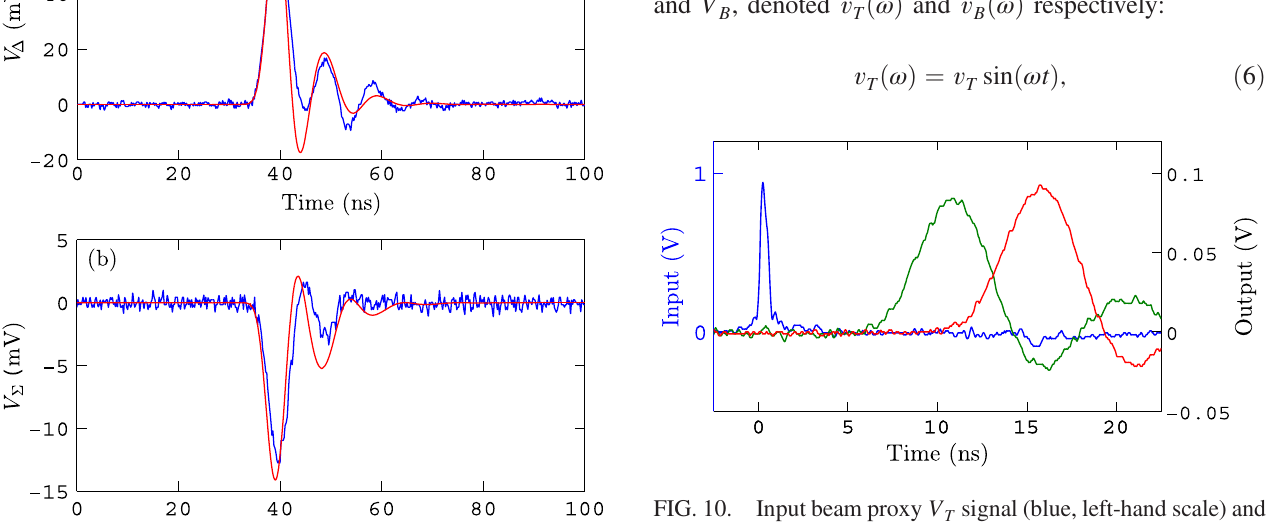
FIG. 10. Input beam proxy V signal (blue, left-hand scale) and T processor output V Δ signal before the amplifier stage (green, right-hand scale, with factor 5 multiplication), and after the amplifier stage (red, right-hand scale), vs time (ns). The amplifier stage delays the output signal by an additional 5.2